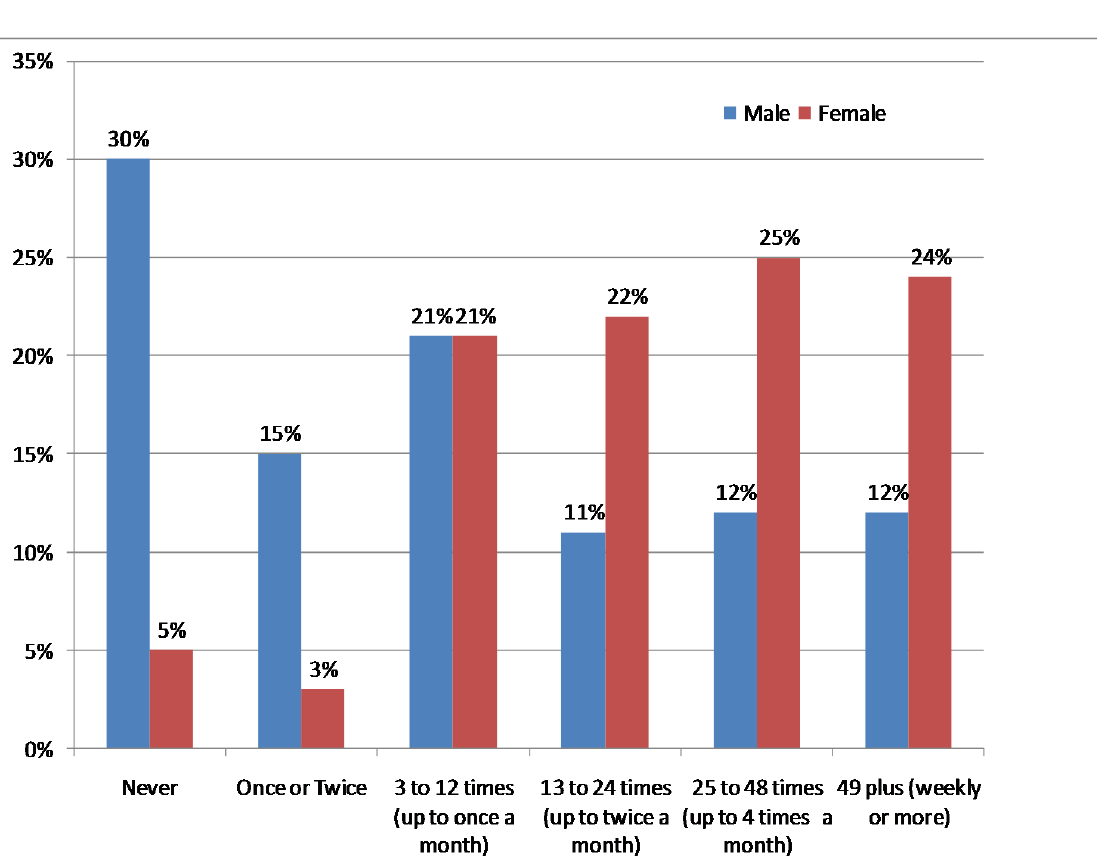
Figure 5. Levels of Attendance During The First Year of Incarceration by Male (N = 3009) and Female (N =